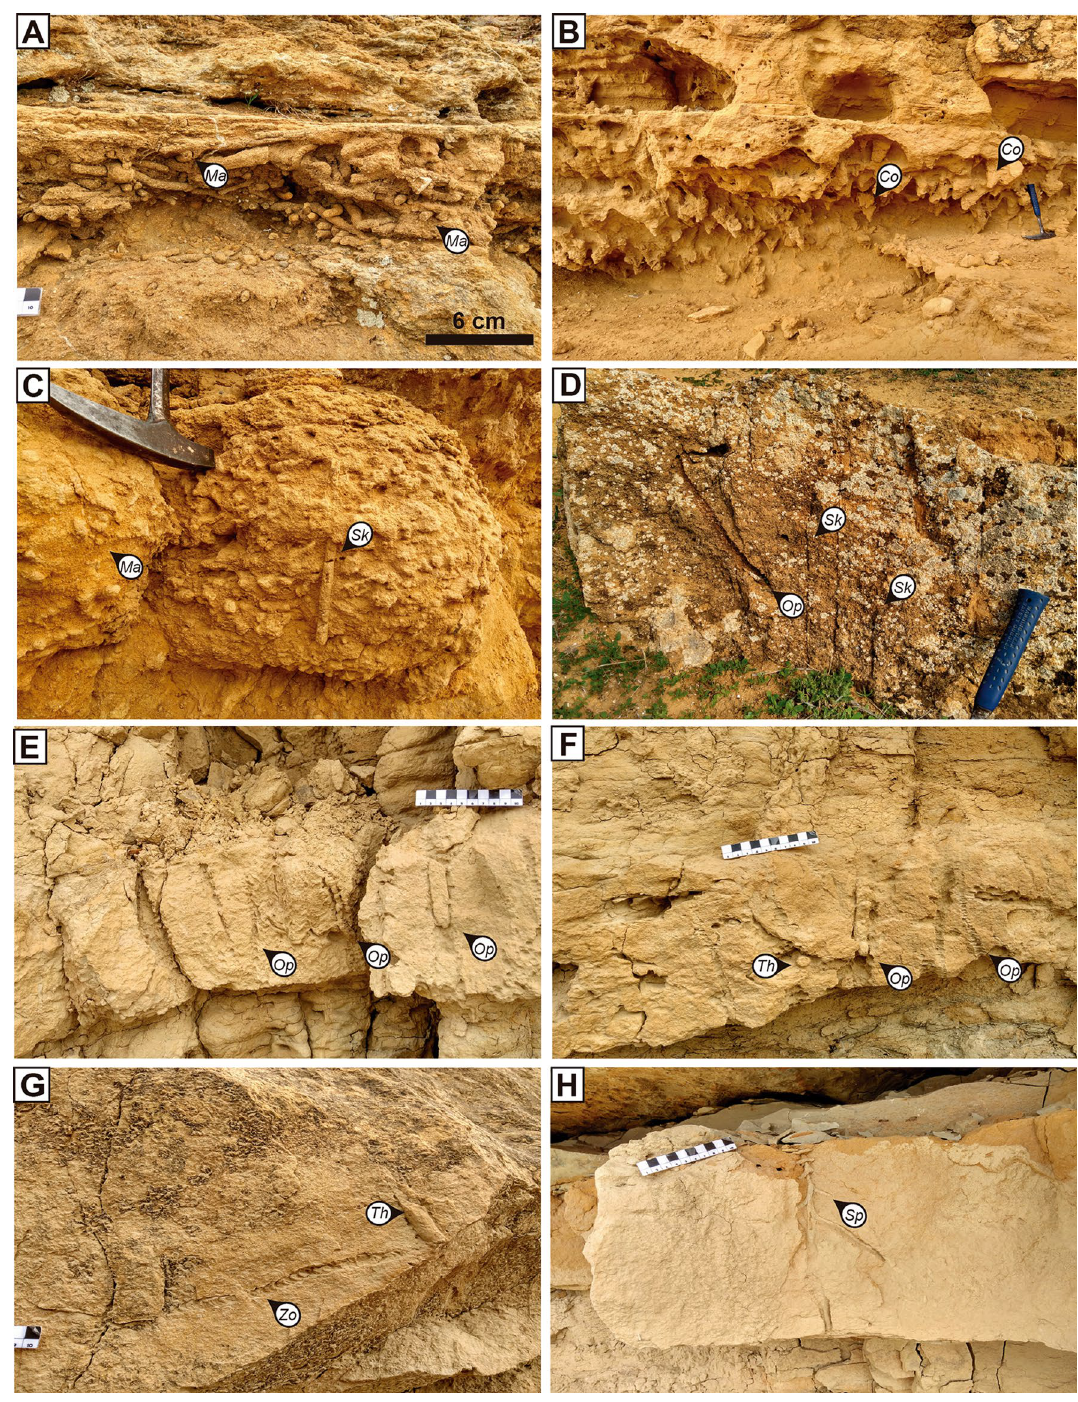
Figure 3. Trace-fossil specimens from shallow marine deposits at Ain Kansera ( A – D ) and turbiditic deposits at Sidi Harazem ( E – H ). ( A ) Close-up view of Macaronichnus at Ain Kansera; ( B ) Densely Conichnus assemblage at Ain Kansera; ( C ) Macaronichnus cross-cut by a Skolithos at Ain Kansera; ( D ) Skolithos and Ophiomorpha at Ain Kansera; ( E , F ) Ophiomorpha ( O. rudis ) at Sidi Harazem; ( G ) Zoophycos cross-cut by a Thalassinoides at Sidi Harazem; ( H ) Close-up view of Spyrophyton at Sidi Harazem. Conichnus ( Co ), Macaronichnus ( Ma ), Ophiomorpha ( Op ), Skolithos ( Sk ), Spyrophyton ( Sp ), Thalassinoides ( Th ), and Zoophycos ( Zo